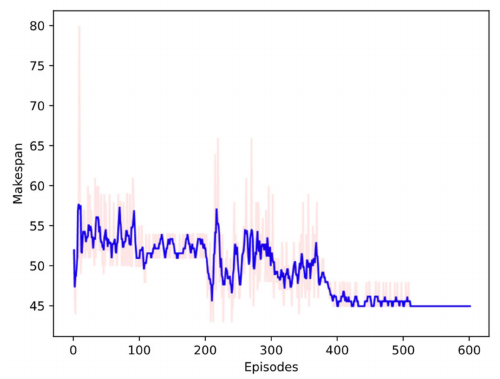
Figure 9. Makespan of each